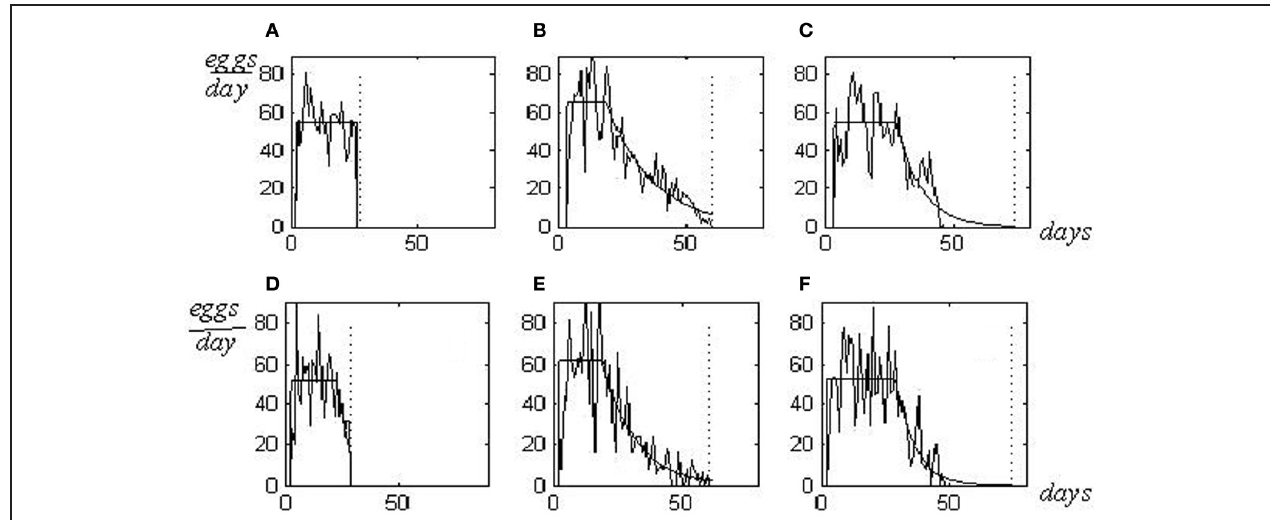
deaths from senescence [ m- and l- flies, plates correspondingly (B,C and E,F )]. Parameters of regularly approximated patterns for to, T , RC , LS and ½ are as follows: 2, 24, 55, 27, 0.02 in s- flies; 3, 16, 66, 60, 18 in m- flies; 3, 16, 25, 55, 74, 10 in l- flies. The in silico values of the parameters a , T and LS are 50, 19, 29 in s- flies; 65, 20, 60 in m- flies, and 55, 26, 75 in l- flies. Vertical dotted lines—the life